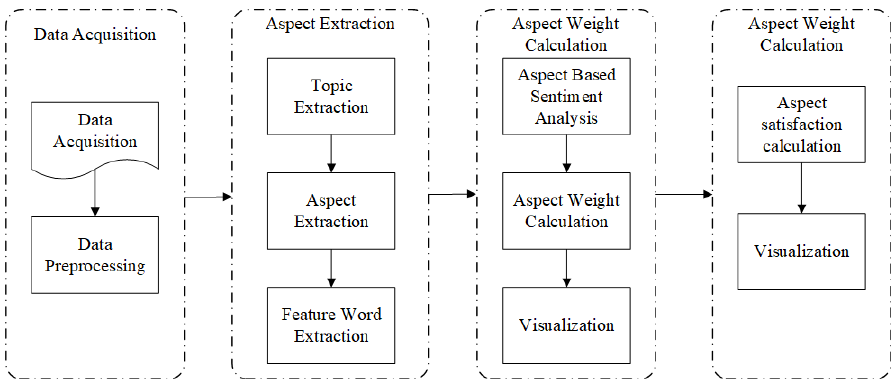
Figure 1. Research